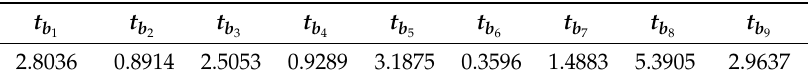
Table 5. t -Statistics.